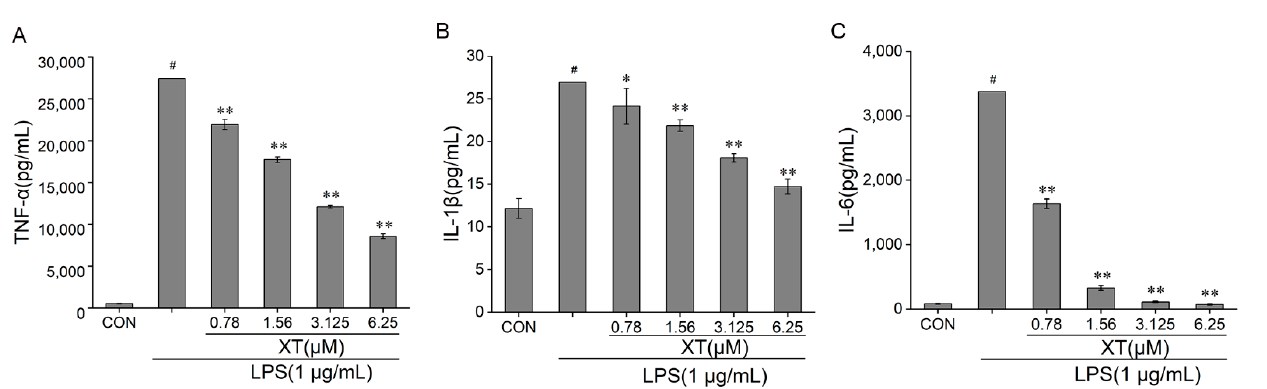
Figure 3. Effects of xanthatin on release of pro-inflammatory factors: TNF- α ( A ), IL-1 β ( B ), IL-6 ( C ). When cells were pre-treated with xanthatin and activated by LPS, the concentration of TNF- α , IL-1 β , IL-6 in the culture supernatants was tested using an ELISA kit assay. Data is shown as means ± SDs (n = 3). #: significantly different compared to the control (CON) group, *: p < 0.05, **: p < 0.01, as compared to the LPS-induced group.